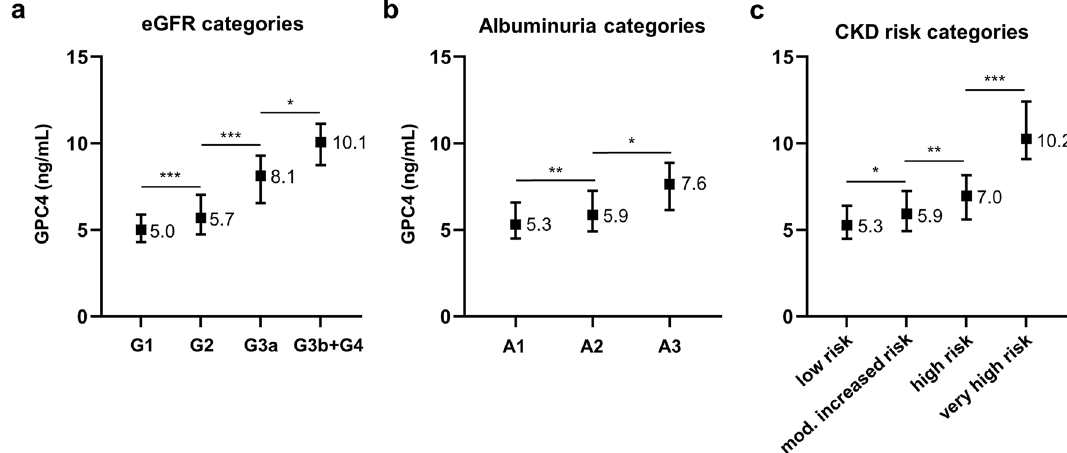
Figure 1. Association between glypican-4 levels and kidney function. Glypican-4 levels are expressed as median with interquartile range. ( a ) Estimated glomerular filtration rate categories are assigned as follows: G1: eGFR ≥ 90 mL/min/1.73 m 2 (n = 196); G2: eGFR 60–89 mL/min/1.73 m 2 (n = 227); G3a: eGFR 45–59 mL/ min/1.73 m 2 (n = 23); G3b: eGFR 30–44 mL/min/1.73 m 2 (n = 9); G4: eGFR 15–29 mL/min/1.73 m 2 (n = 1);